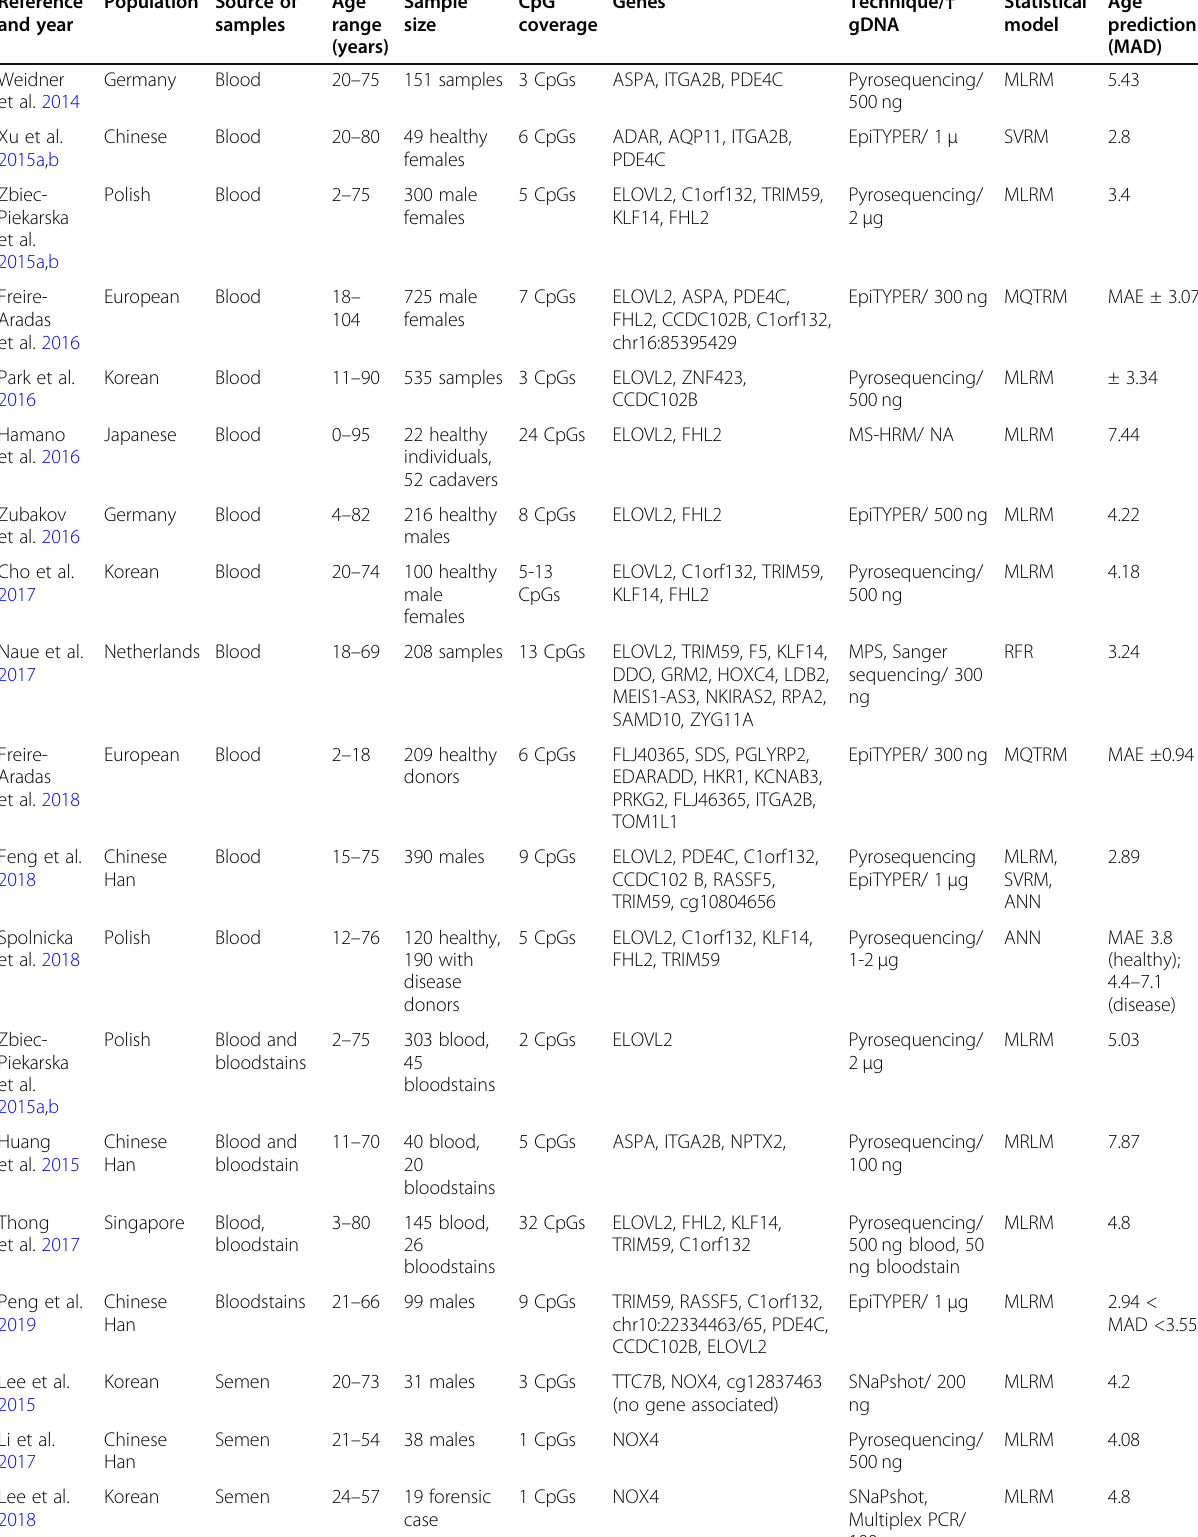
Table 2 DNA methylation methods for age estimation in forensic